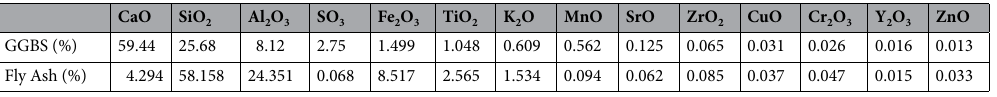
Table 1. Chemical constituents of fly ash and GGBS used in the